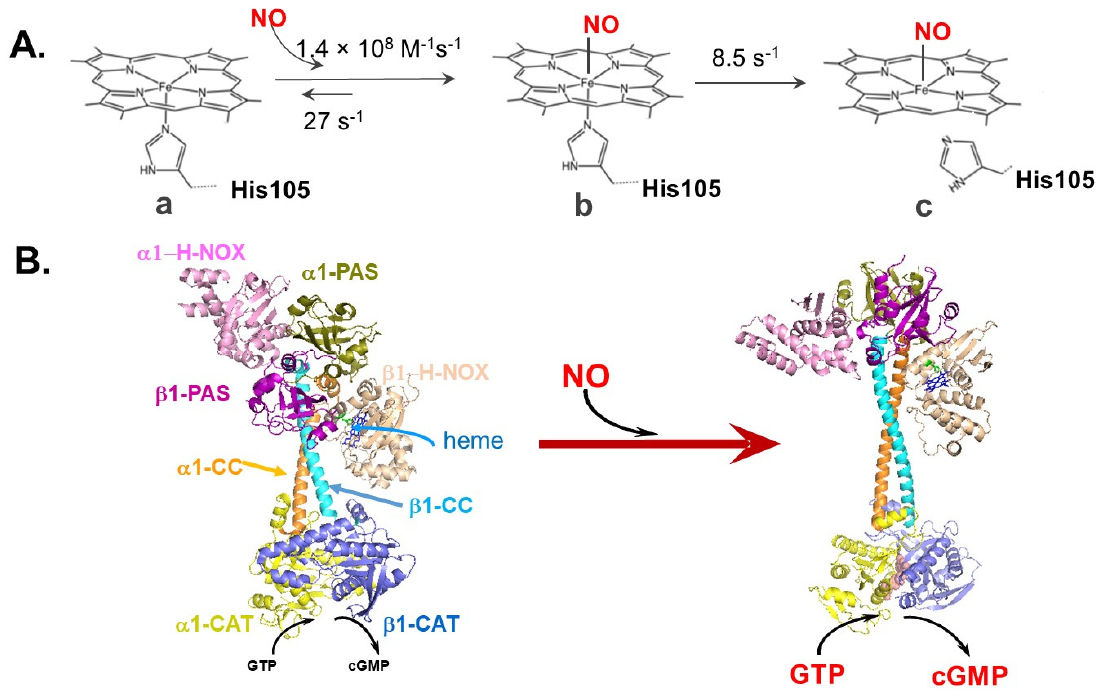
Figure 1. Structural changes of SGC in response to NO-dependent activation. ( A ): Schematic representation of the process of NO:-SGC adduct formation. The five-coordinate heme moiety of SGC (state a) binds NO to form a six-coordinate complex (state b). The six-coordinate complex subsequently converts irreversibly into a five-coordinate complex (state c) due to the rupture of Fe-His105 bond. Corresponding reaction rates are indicated. ( B ): Structural rearrangement of different SGC domains that occurs following NO binding causes significant activation of cGMP-forming activity.